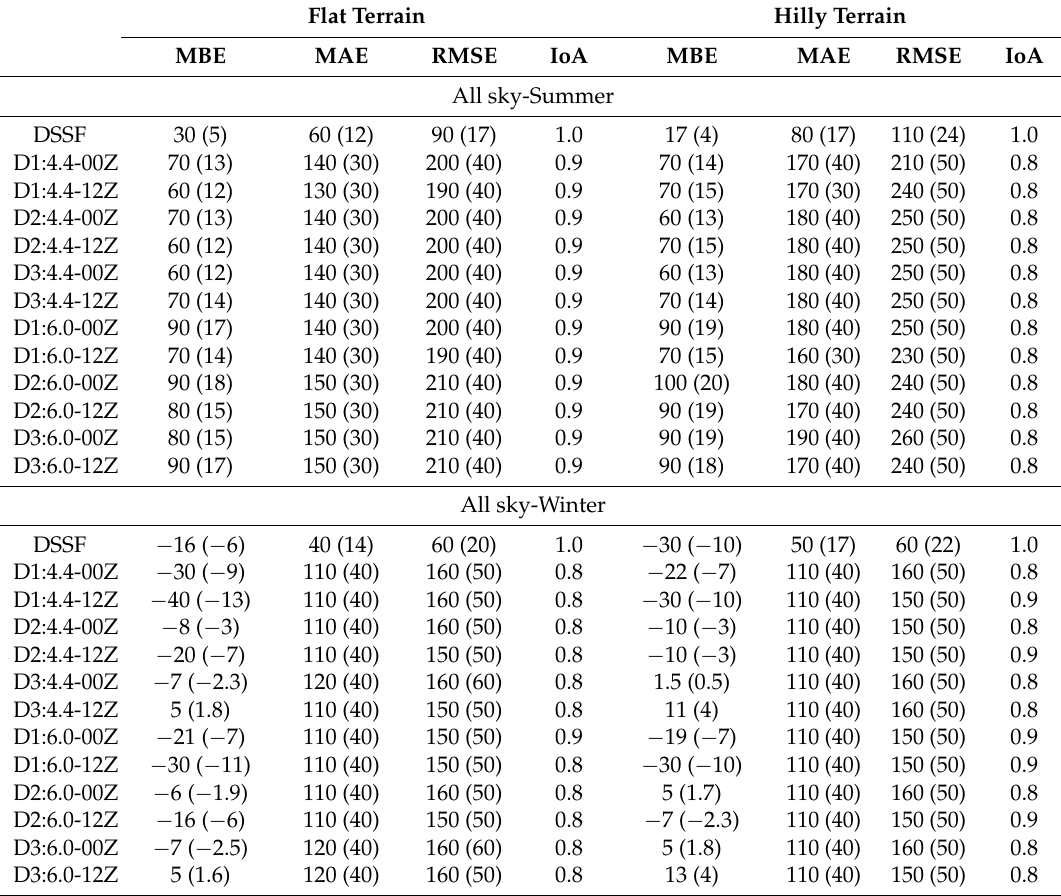
Table 4. Hourly solar radiation error and accuracy statistics, depending on flat or hilly terrain and considering all sky conditions, during the summer 2011 and the winter 2010–2011. MBE, MAE and RMSE in W ¨ m ´ 2 . Relative errors (%) rMBE, rMAE and rRMSE in brackets at the right. Flat